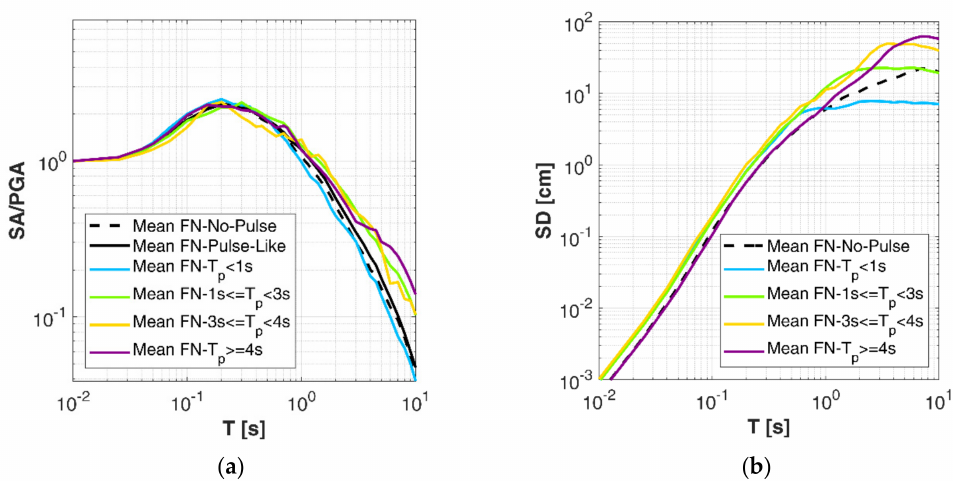
Figure 4. Mean 5% damped acceleration response spectra SA divided by PGA ( a ) and displacement spectra SD ( b ) in log-log scale, grouped by 4 pulse period bins.